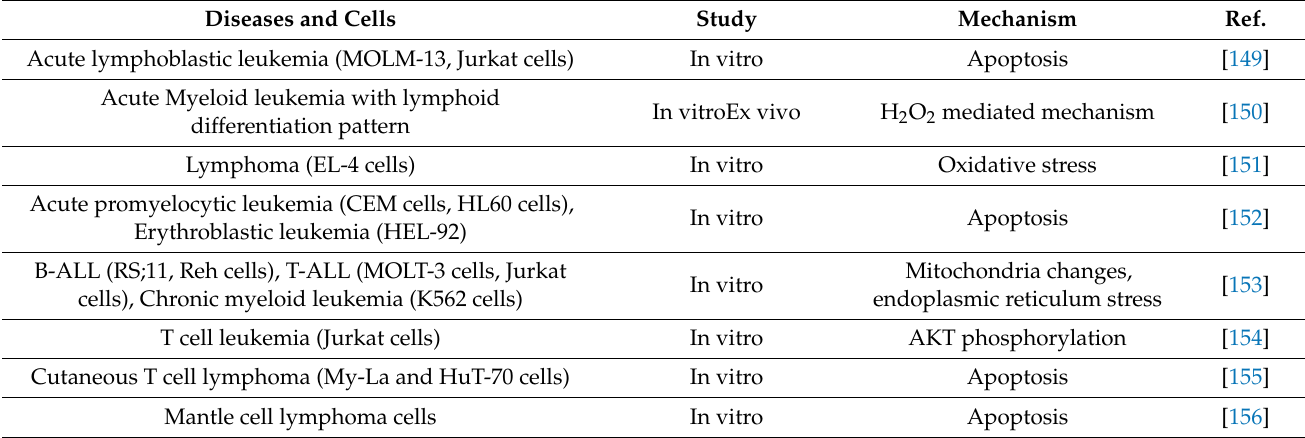
Table 3. Effects of CBs in preclinical studies on hematological malignancies. Diseases and Cells